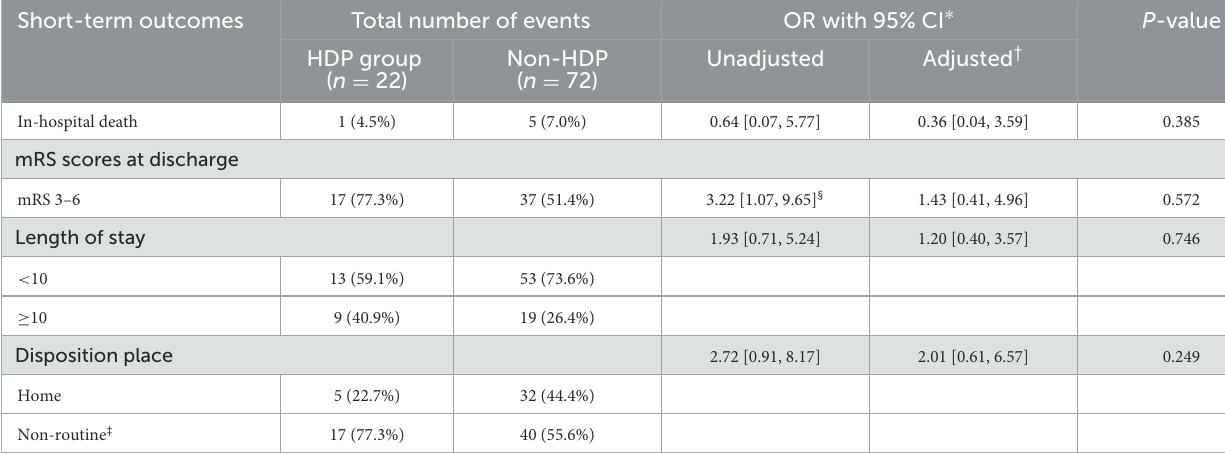
TABLE 3 Odds ratios (ORs) with confidence interval (CI) ∗ for short-term outcomes by hypertensive disorders of pregnancy (HDP) status among pregnancy-related hemorrhagic stroke.